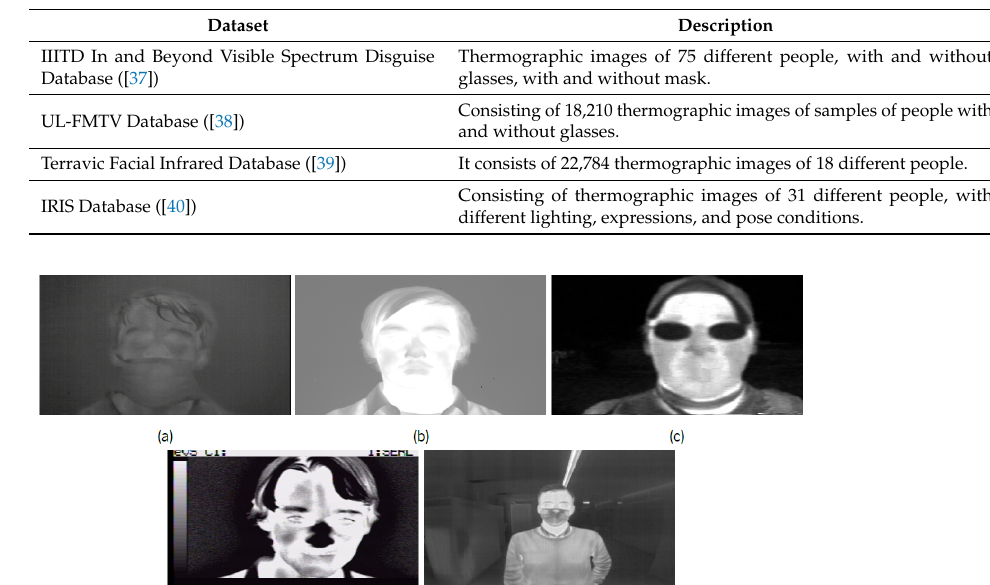
Table 2. Thermographic datasets collected for training of mask, goggles, and caruncle zone detection algorithms.